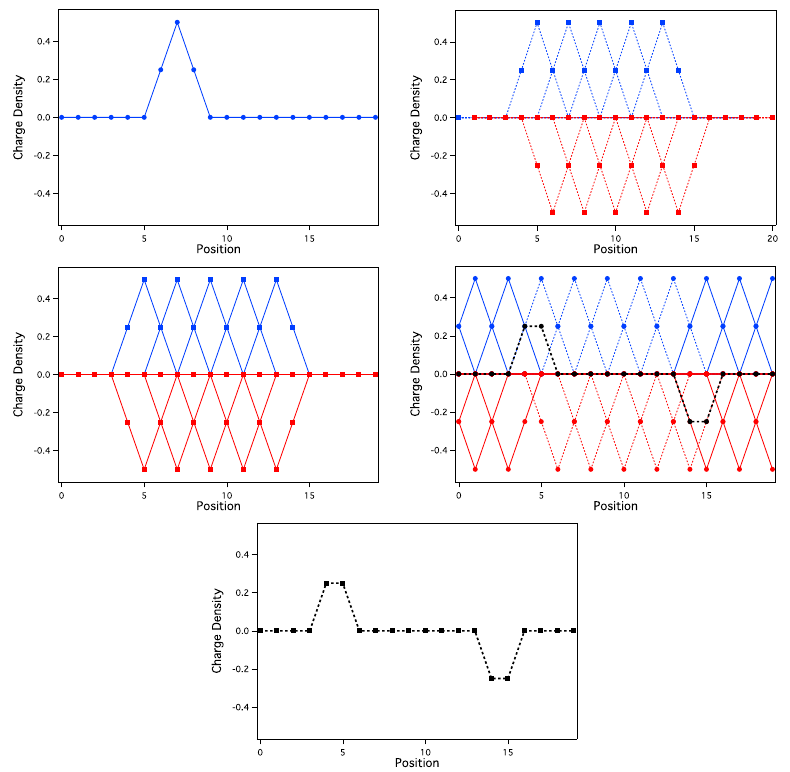
Figure 4: Simple 1D model to illustrate e on the ends of a 1D chain. (top left) The 2 simple “ion" unit that has + 1 integrated unit of charge spread out over space. (top right) Charge unit arranged in Type I lattice with alternating positive and negative charge units. Note that system is neutral in bulk. (middle left) Charge units arranged in Type II lattice with positive and negative charge units on top of each other. (middle right) Type I lattice sandwiched between pieces of Type II lattice. Black represents the sum at each point of the net local charge. (bottom) Replotted net local charge. Integrated charge density at ends of chain shows that e charges are located at the 2 interface of the Type I and Type II